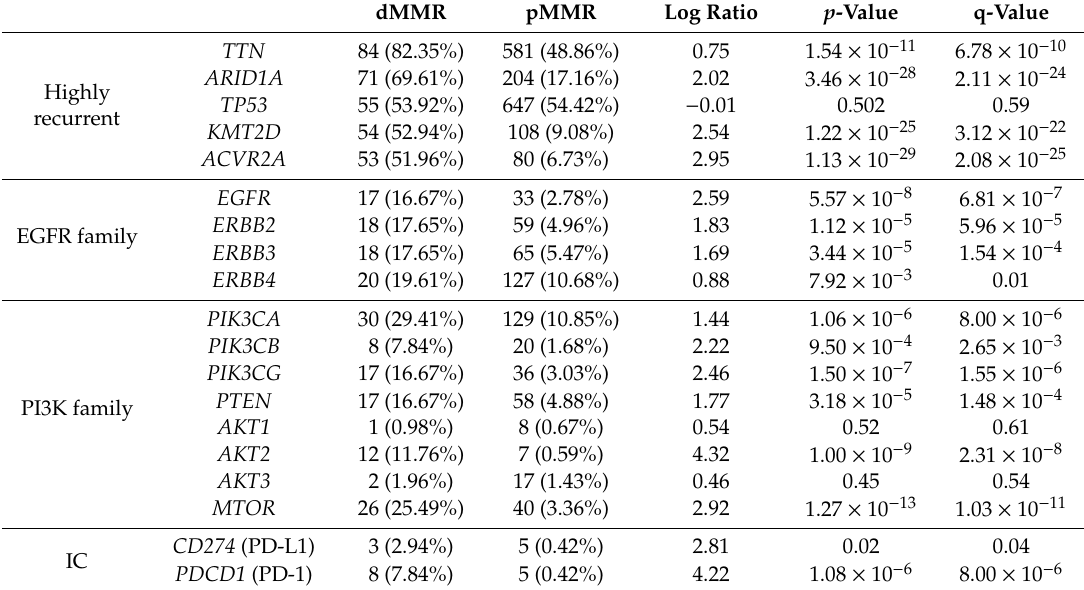
Table 1. Association between highly recurrent mutations and mutations targeting relevant cancer genes with the MMR status in patients with gastroesophageal cancers. p -value was calculated via the Fisher Exact test; q-value was derived from the Benjamini–Hochberg procedure (cBioPortal.com).